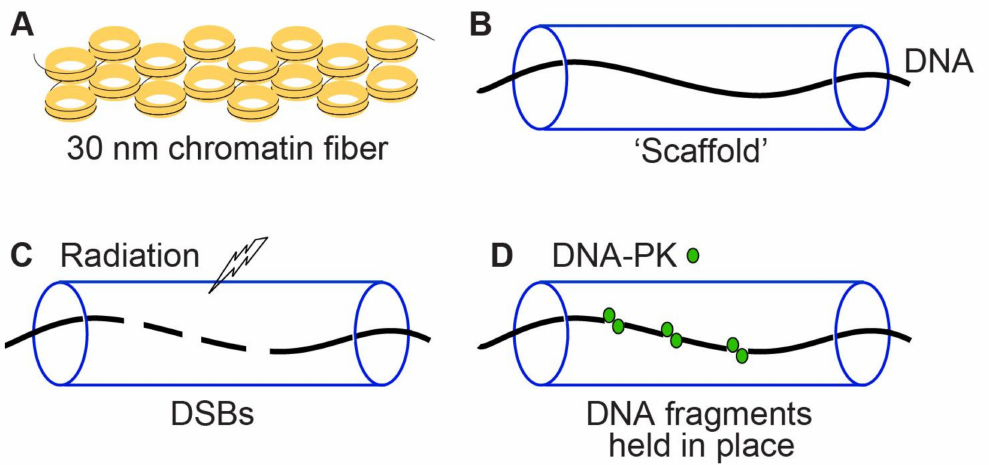
Figure 5. Two potential mechanisms to prevent DSB mis-repair and loss of DNA fragments at